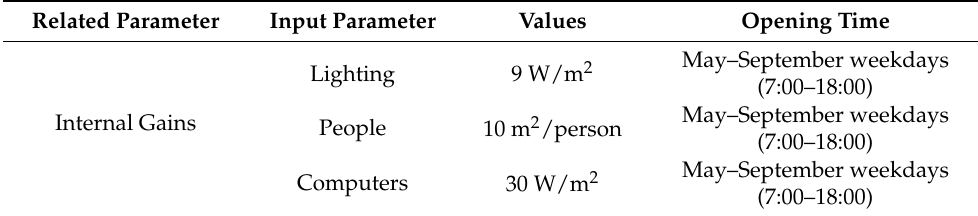
Table 10. Internal gains for the